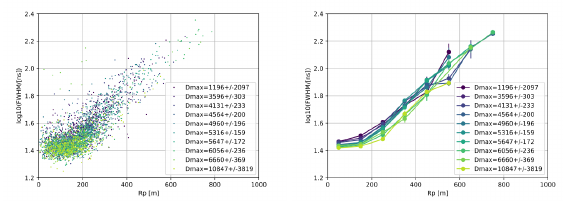
Figure 8. Left: The log FWHM vs R P distribution for events 10 with various D max values. The D max values in the legend are in meters and the uncertainty represents the width of the D max bin. Right: A profile plot of the same with the < log FWHM > vs 10 shown vs R P distribution for events with various D max values..